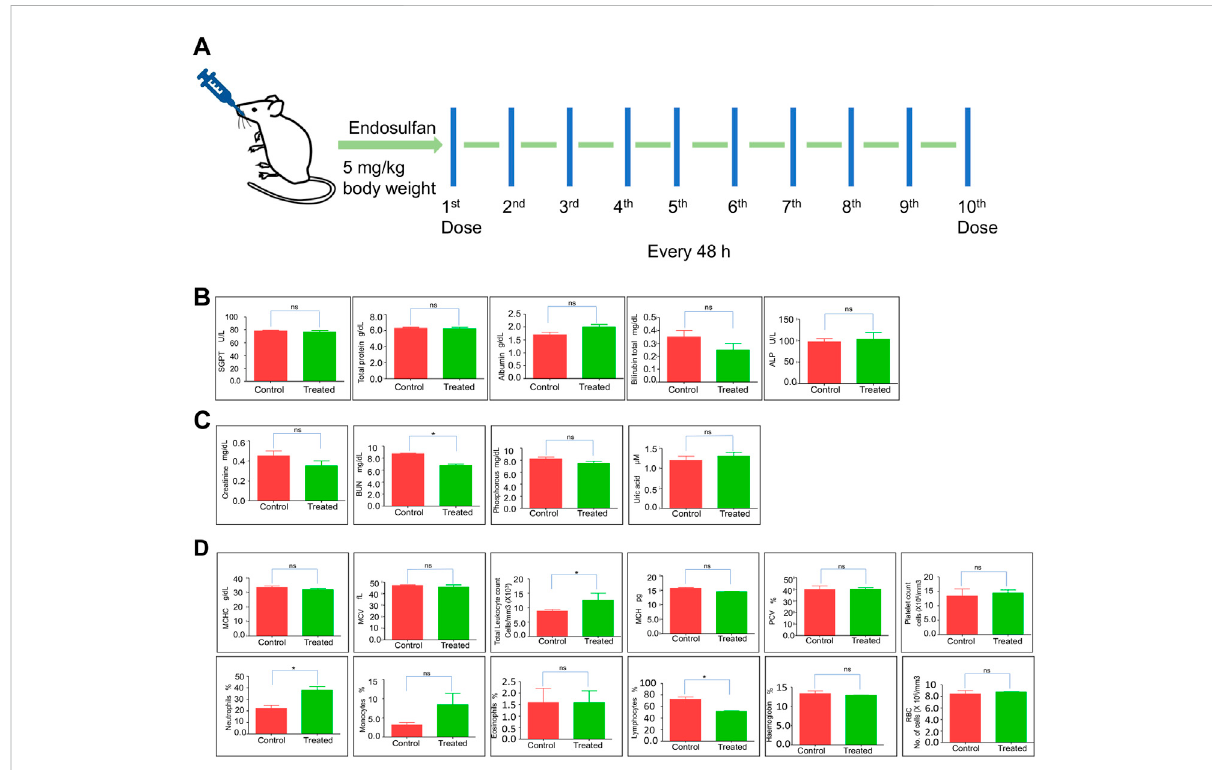
FIGURE 2 Evaluation of physiological effects of ES in mice. (A) Schematic representation of ES-treatment in mice. Mice were exposed to 5 mg/kg body weight of ES through oral gavage every alternate day for 10 doses. (B,C) Liver and kidney function test of ES-treated mice. Bar graphs indicating enzymatic activities re fl ective of liver and kidney function at 31st day after ES treatment (5 mg/kg, n = 2). (D) Blood parameter analysis following oral administration of ES in mice after 31st day ( n = 2). Analysis of red blood cells (RBC), white blood cells (WBC), haemoglobin (HGB), platelets,